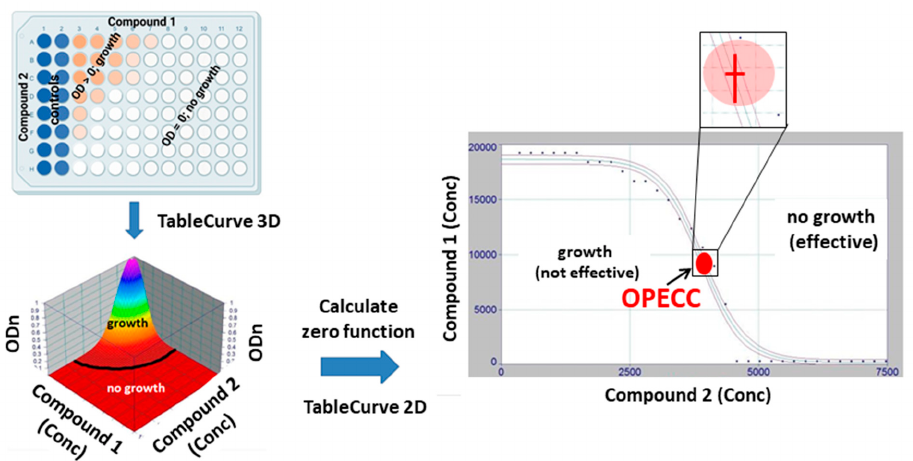
Figure 2. OPECC ( Optimal Effective Concentration Combination ) calculation. From a checkerboard plate ( top left panel ), the normalized OD values (ODn; z -axis, bottom left panel ; ODn = OD values from plates incubated for 180 min, normalized to their baseline (0 min) values) were plotted against the respective concentration combination pairs ( x-y plane) and fitted three-dimensionally (TableCurve 3D), with the result being z = f (x,y) ( bottom left panel ; colored 2 dimensional surface in 3 dimensional space). ODn = 0 is equivalent to no growth, thus indicating effective concentration combinations, whereas ODn > 0 is equivalent to growth, and, thus, non-effective concentration combinations. The set of 2-dimensional intersection points of this function f with the x-y plane was determined by applying the condition z = f (x,y) = 0 (black curve in panel bottom left separating no growth (effective concentration combinations) and growth (non-effective concentration combinations)). The points of this solution set in the 2-dimensional x-y (concentration) space were fitted 2 dimensionally (TableCurve 2D) and displayed together with their corresponding 95% confidence intervals ( right panel ). The inflection point (red dot) and the corresponding 95% confidence limits in both dimensions (insert) were determined ( right panel ) and used as describing parameters for the presentation of the results of the study. This inflection point was denominated as the optimal effective concentration combination (OPECC).